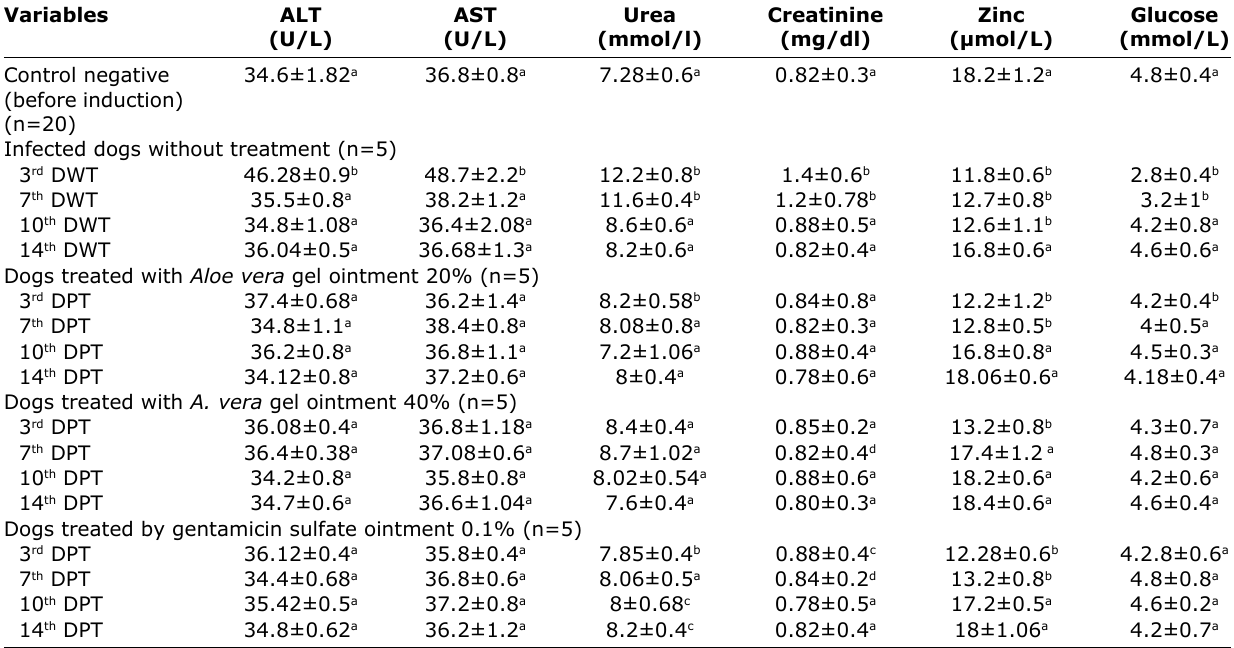
Dogs treated by gentamicin sulfate ointment 0.1% (n=5)